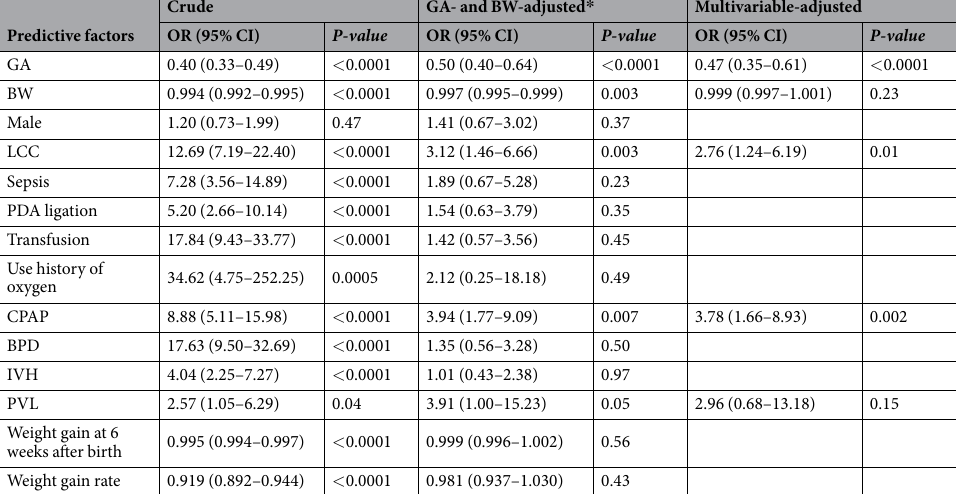
Table 3. Predictive factors for TR-ROP in all infants. Abbreviations: TR-ROP, treatment-requiring retinopathy of prematurity; GA, gestational age; BW, birthweight; OR, odds ratio; CI, confidence interval; LCC, late- onset circulatory collapse; PDA, patent ductus arteriosus; CPAP, continuous positive airway pressure; PMA, postmenstrual age; BPD, bronchopulmonary dysplasia; CNS, central nervous systems; IVH, intraventricular hemorrhage; PVL, periventricular leukomalacia. * GA is BW-adjusted and BW is GA-adjusted.